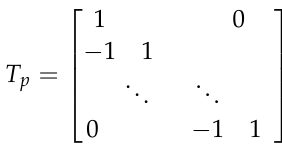
column of the transformation matrix is